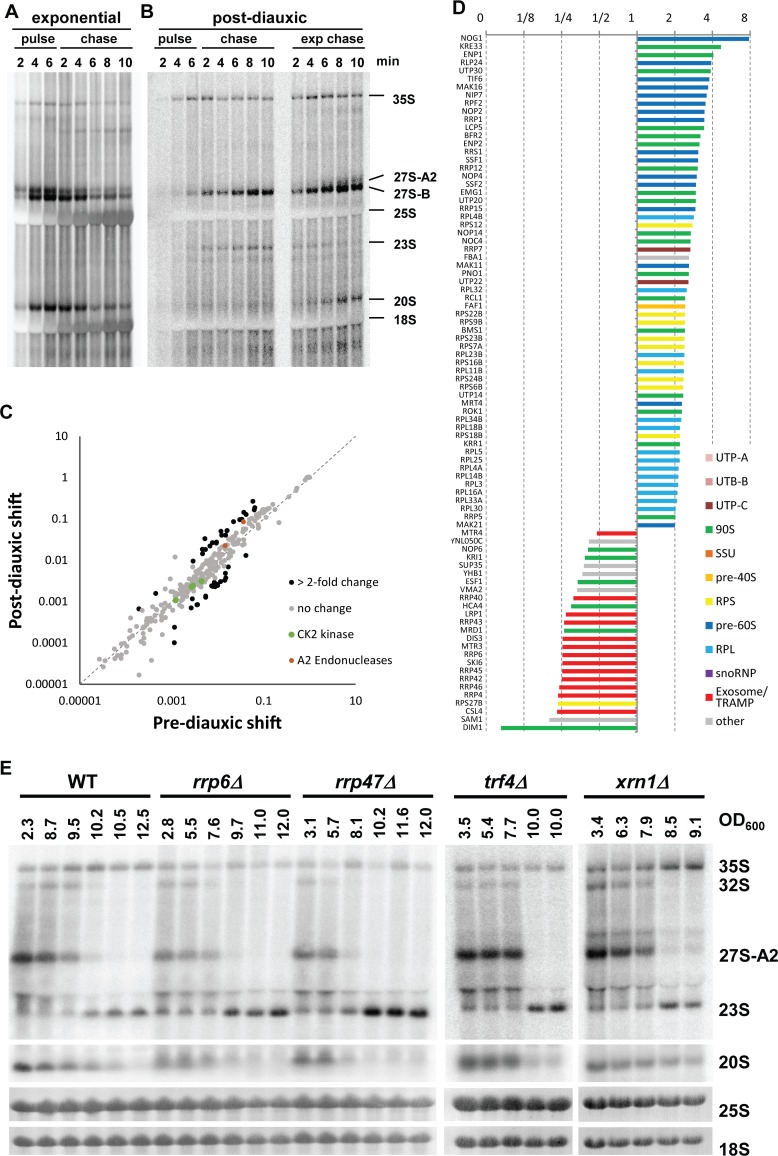
In vivo pulse-chase and proteomic analyses of the pre-rRNA processing in exponential and postdiauxic shift cultures.(A) Low density (OD600 = 2) YMK118 was pulse labeled in vivo with 3H-uracil for 6 min and then chased with nonradioactive uracil for 10 min. (B) Yeast culture in early postdiauxic phase (OD600 = 10) was pulse labeled for 6 min. The culture was split, and one-half was chased for 10 min, as in (A) (on the left). To the other half of the culture, fresh media and no-radioactive uracil was added to the same final concentration and chased for 10 min (right side, “exponential chase”). (C) Comparison of intensity based absolute quantification (iBAQ) values normalized to bait of 324 proteins detected in the affinity purified preribosomes from pre- and postdiauxic cultures. Proteins changed more than 2-fold are in black. (D) Histogram of SILAC Heavy/Light (H/L) ratios (normalized to bait) for proteins with more than 2-fold change in the preribosomes purified from postdiauxic shift versus prediauxic shift cultures (for high resolution see S7 Fig). An experiment with a higher coverage is shown. Underlying numerical data are in S1 Data. (E) Northern blot analysis of RNA isolated form wild-type yeast or strains deleted for different exosome/TRAMP complex factors or Xrn1. All strains were grown until their growth stopped after the diauxic shift. The xrn1Δ strain stopped growing at the indicated lower OD600 than the other strains.